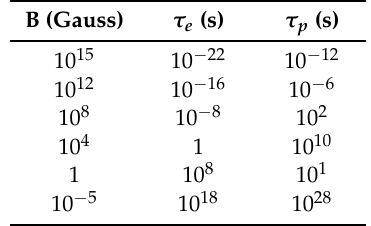
Table 5. Energy decay times of electrons ( τ e ) and protons ( τ p ) orbiting a black hole immersed in a uniform magnetic field with values of B characteristic for various astrophysical